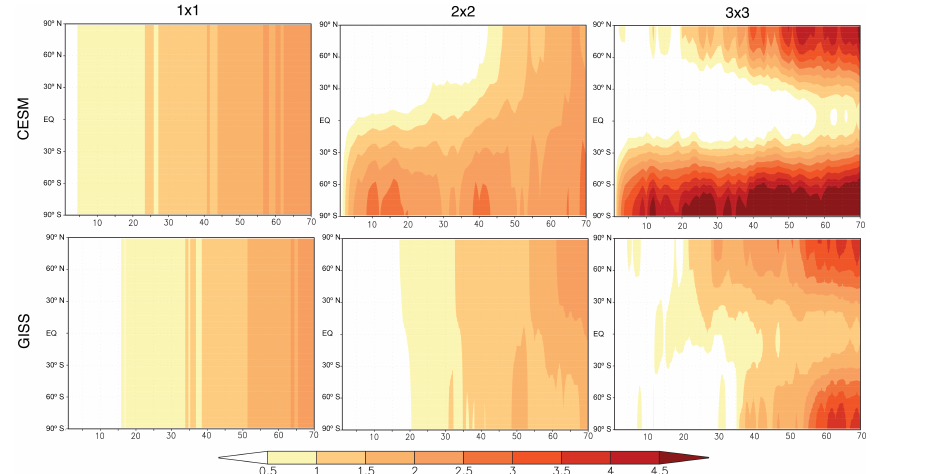
Figure 18. Percent reduction in insolation for the 3 × 3 design case. The left column is the 1 × 1 simulation (offsetting T 0 changes via L 0 changes), the middle column is the 2 × 2 simulation (offsetting T 0 and T 1 changes via L 0 and L 1 changes), and the right column is the full 3 × 3 simulation. The top row corresponds to the design model, and bottom row is the evaluation model. All results are zonally and annually averaged.